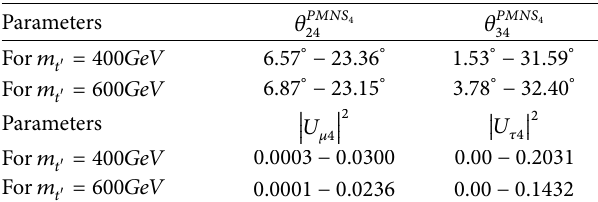
Table 3: The limits obtained on sterile mixing angles.